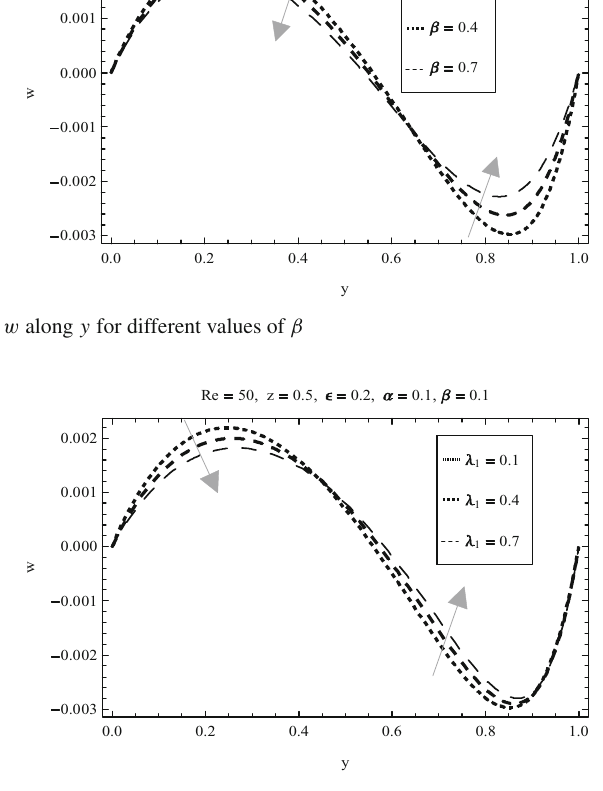
Fig. 12 Velocity component w along y for different values of λ 1